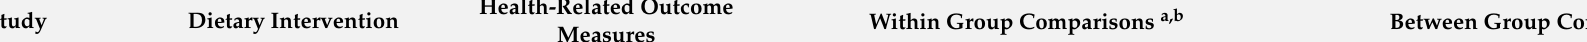
Table 4. Health-related outcome measures of the included studies, grouped and listed in order of health condition discussed in the